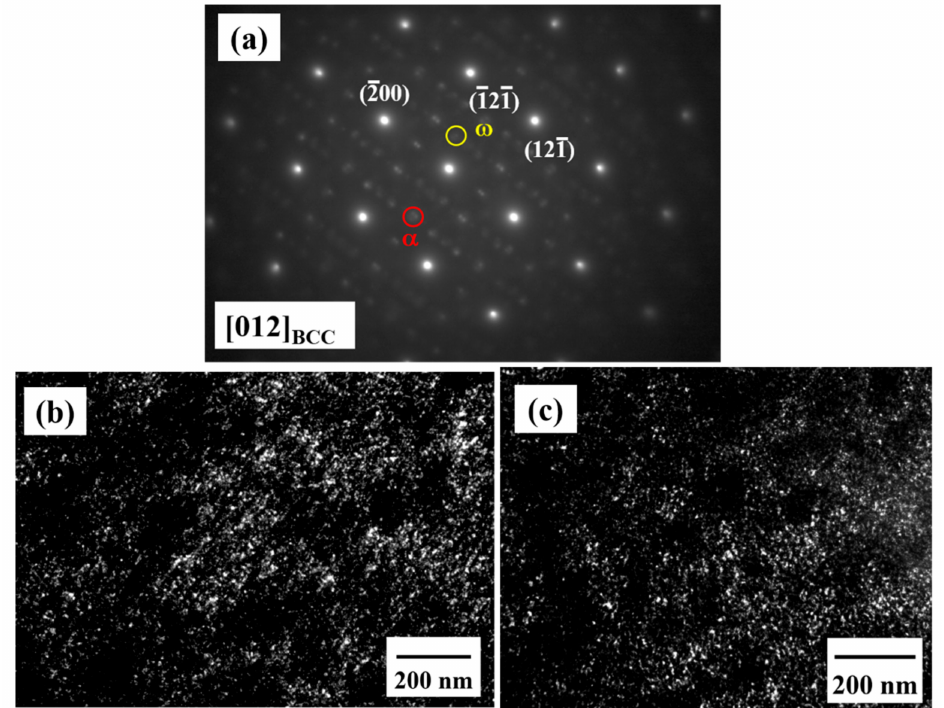
Figure 8. TEM results of the α and ω precipitates in the as-homogenized alloy: ( a ) SADP of the [012] BCC zone axis; ( b ) dark-field image taken from the α spot, as highlighted by the red circle in SADP; and ( c ) dark-field image taken from the ω spot, as highlighted by the yellow circle in